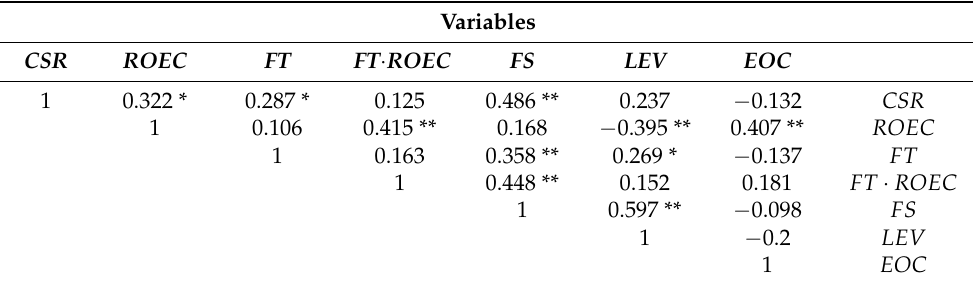
Table 5. Correlation